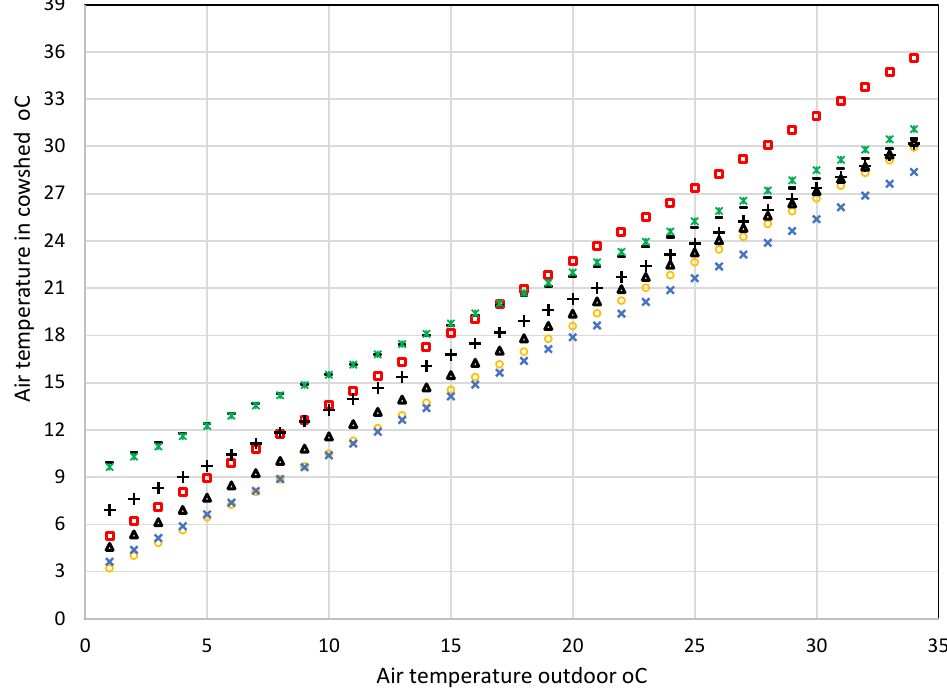
Figure 4. Air temperatures in cowsheds related to outdoor temperatures. The air temperature in the semi-warm cowshed rises above 25 °C from 13:00 until 20:00 (Figure 5), an average of 7 h during the day. Such temperatures occur in semi-warm cowsheds (cowshed four; cowshed six) on average throughout July. The maximum tem- perature is 16: 00–17: 00, it rises to 27.29 ± 0.16 °C. Analyzing temperatures from 7:00 p.m. until 20:00, we found that the temperature in the cowshed was on average 0.56 ± 0.12 °C higher than outside. The fans installed in the cowsheds do not cool the barn, they only intensify the convective heat exchange between the animal and the ambient air.